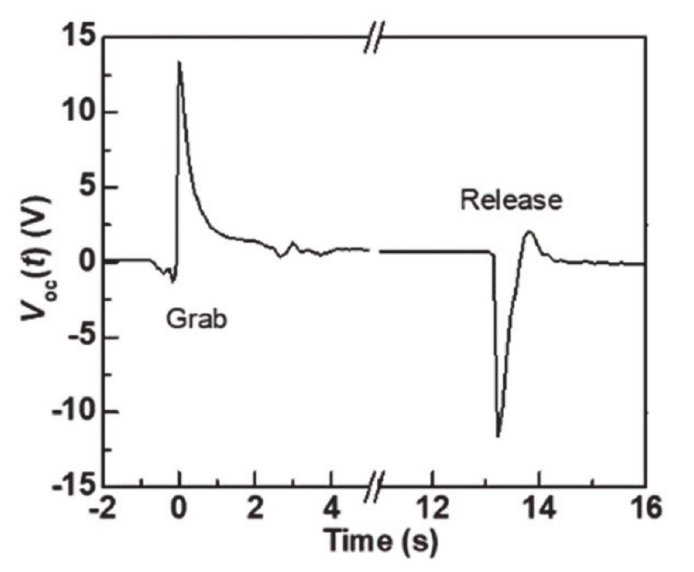
Figure 9. Open circuit voltage with time when the robotic arm grabbed and released the